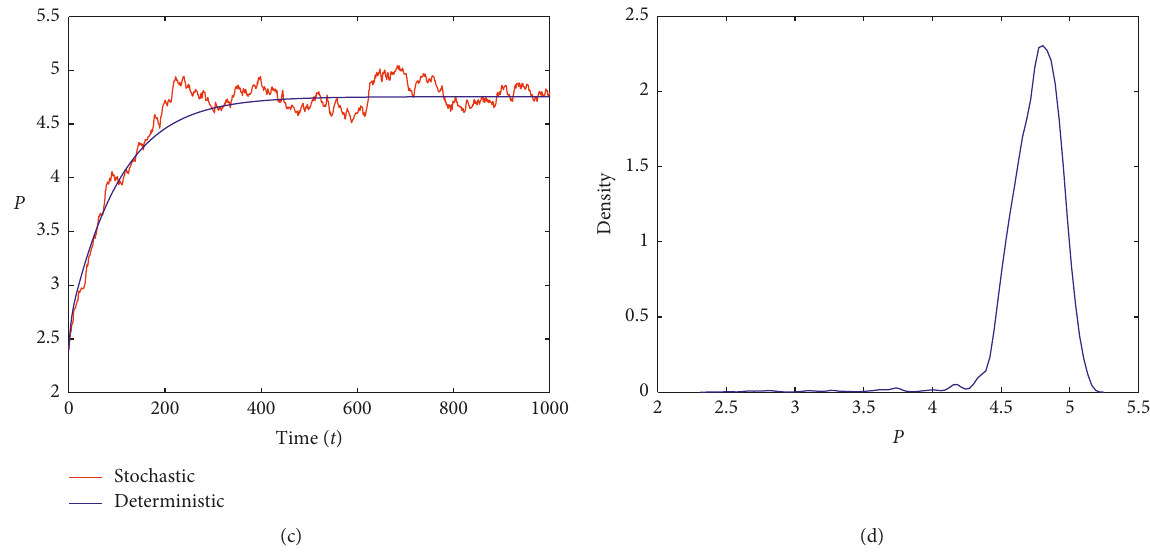
Figure 4: (a) and (c) are the solutions of nutrient and phytoplankton in the stochastic model (3) and its corresponding deterministic model , P ) � ( 8 . 5 , 2 . 4 ) , respectively. (b) and (d) are the probability density function of nutrient and phytoplankton in (1) with initial value ( N 0 0 model (3), respectively.